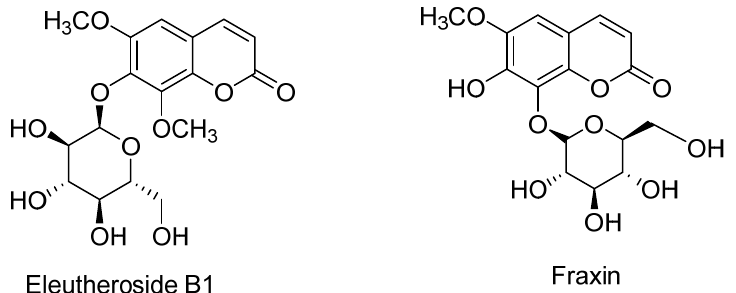
Figure 1. Chemical structure of Isofraxidin (7-hydroxy-6, 8-dimethoxy coumarin) (IF) and other selected coumarin compounds.